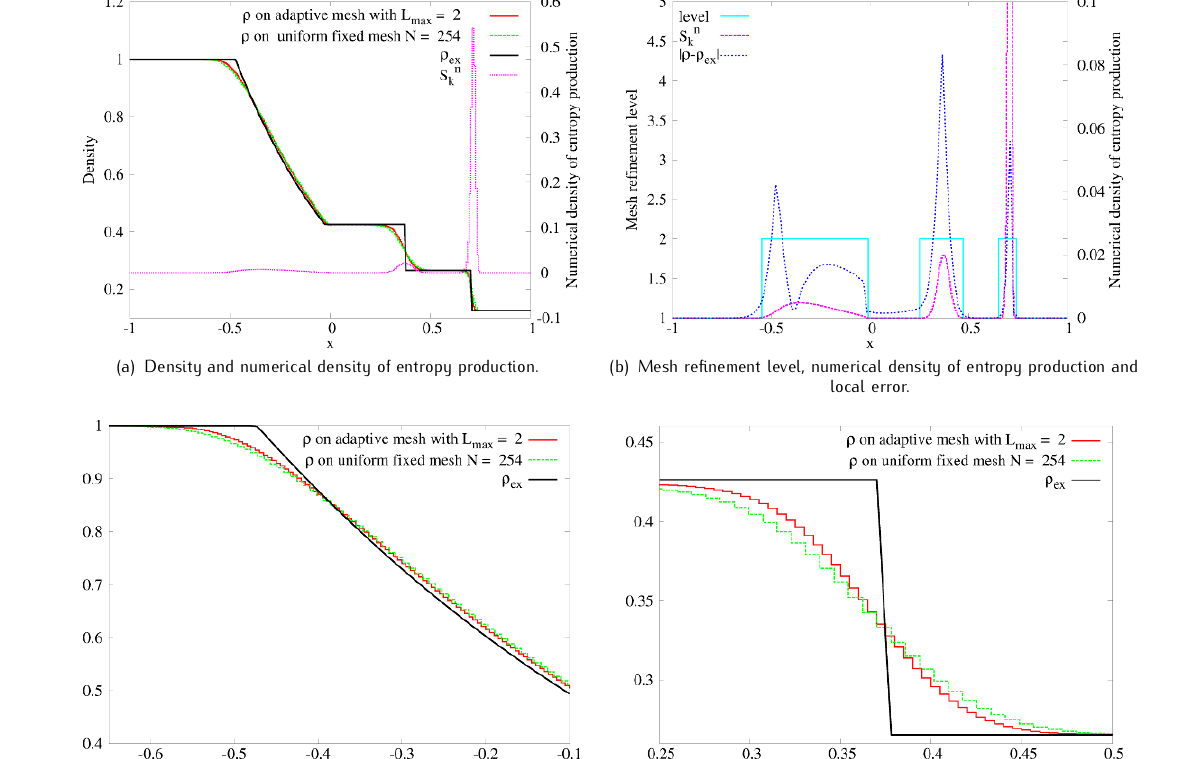
The rate of convergence is considerably increased by the adaptive scheme and, in our experiences, it can be improved by changing the threshold parameters α min and α max at the expense of the CPU-time. With the present threshold parameters, the order of the AB1M scheme is approximately